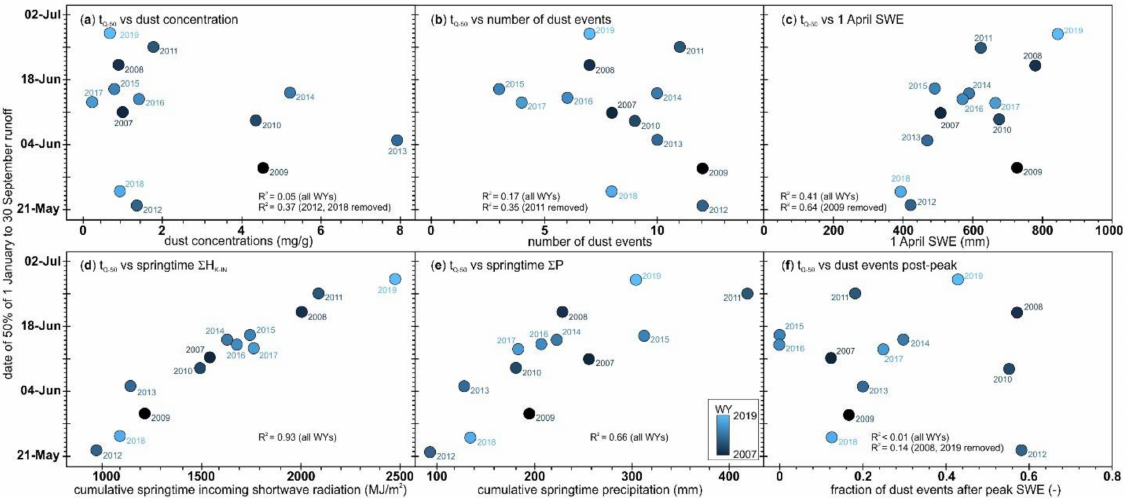
Figure 10. Comparison of half flow date (t Q50 ), as a function of ( a ) end-of-year dust concentration, ( b ) number of dust events, ( c ) 1 April SWE, ( d ) cumulative springtime (1 April to SAG) incoming shortwave radiation, ( e ) cumulative springtime (1 April to SAG) precipitation, and ( f ) the fraction of the dust events after peak